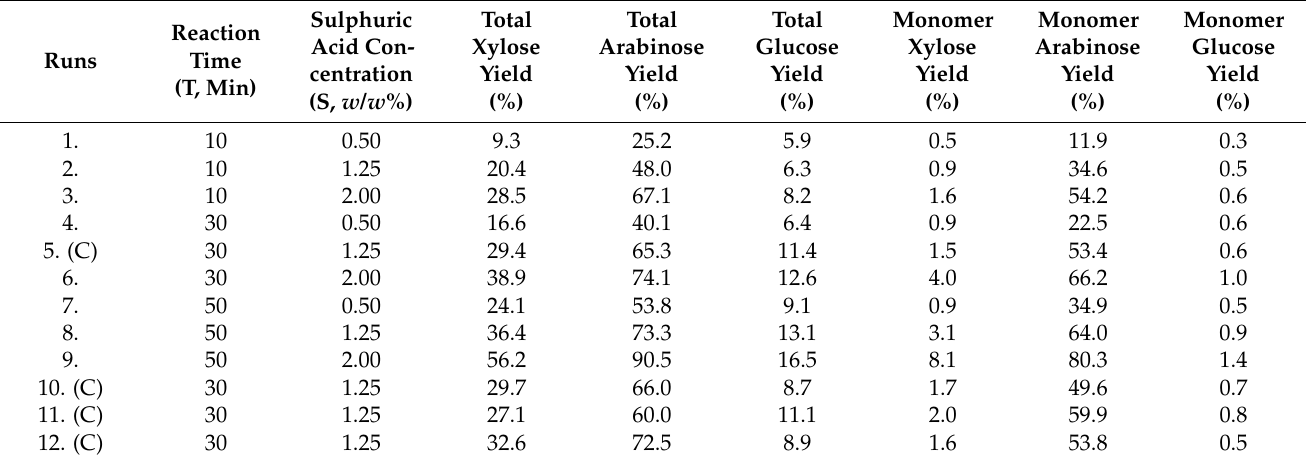
Table 1. The experimental setup and results of the first acidic hydrolysis of